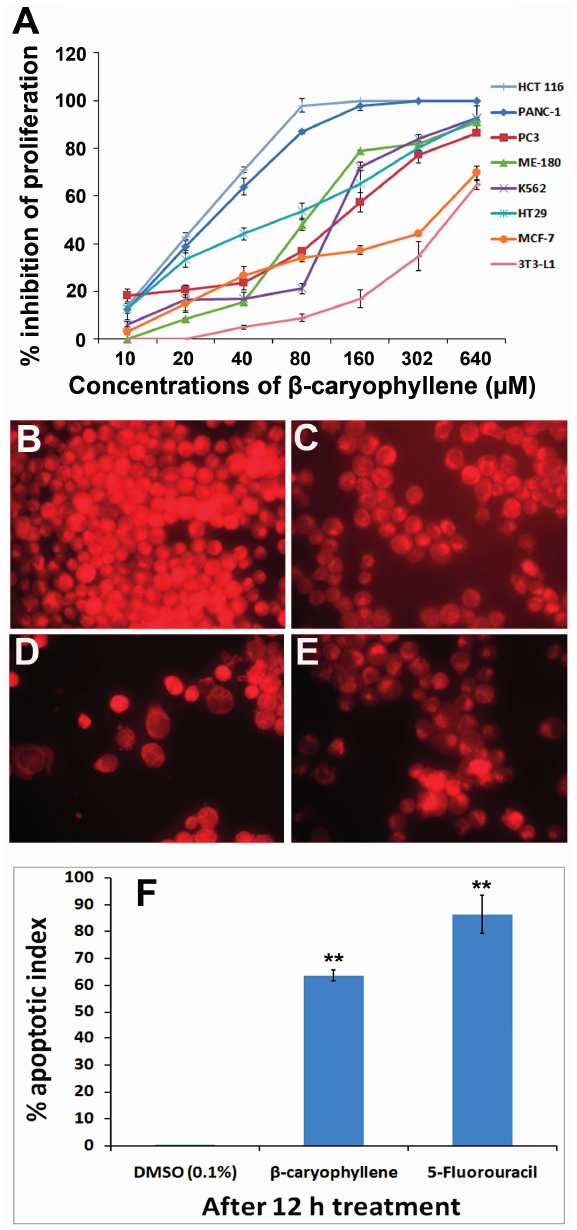
Figure 5. ( A ) Dose-dependent anti-proliferative effect of β -caryophyllene on, HCT 116, PANC-1, HT-29, MCF-7, PC3, K562, ME-180 and NIH/3T3-L1 cell lines was assessed by MTT-assay (values are represented as mean ± SD, n = 3); ( B ) Rhodamine 123 stained photomicrographic images of HCT 116 cells treated with vehicle (0.1% DMSO); ( C ) Rhodamine 123 stained photomicrographic images of HCT 116 cells treated with β -caryophyllene (10 µM) for 6 h; ( D ) Rhodamine 123 stained photomicrographic images of HCT 116 cells treated with β -caryophyllene (10 µM) for 12 h; ( E ) Rhodamine 123 stained photomicrographic images of HCT 116 cells treated with 5-flourouracil (10 µM) for 12 h; ( F ) Graphical representation of percentage of apoptotic indices. The apoptotic index for each test group was expressed as a percentage of the ratio of number of unstained cells to the total number of cell in 10 different microscopic fields. Values are presented as mean ± SD ( n = 10), ** represents p <